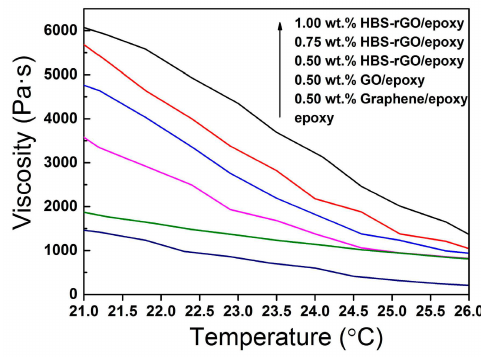
Figure 9. The viscosity behavior of epoxy resin based